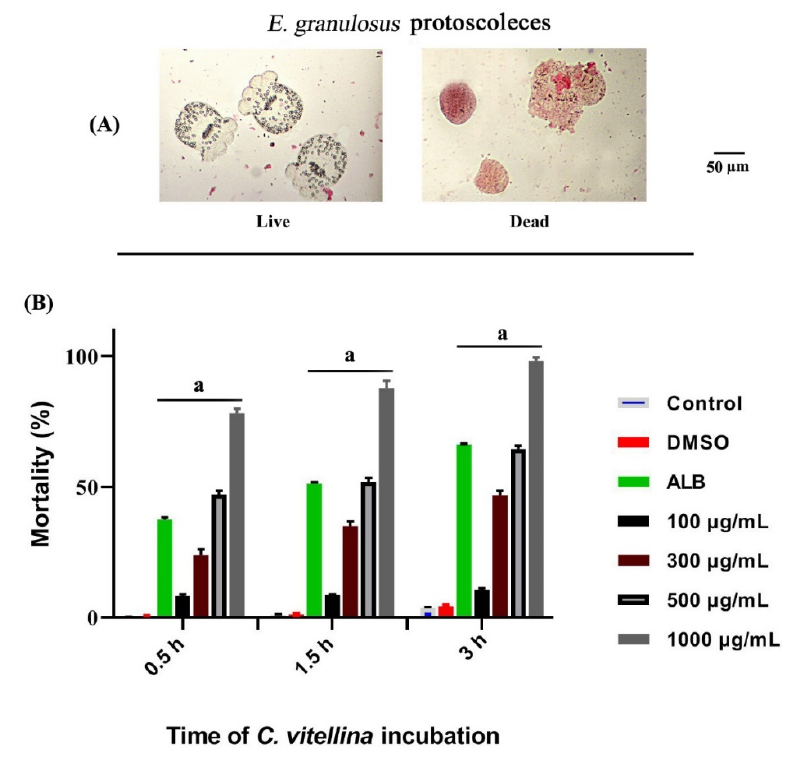
Figure 7. Representative photomicrograph of E. granulosus protoscoleces (Olympus BX 41 light microscope, Tokyo, Japan) showing the morphology of alive and dead protoscoleces after eosin staining ( A ). The mean percentage of mortality rates of protoscoleces after the exposure to various concentrations of C. vitellina extract for 0.5, 1.5 and 3 h were illustrated in ( B ). Significant differences at ( p ≤ 0.05) with respect to untreated groups is represented as (a). Data were represented as (Mean ± SD) of three different experiments (n = 3). ALB: albendazole (50 µg/mL).